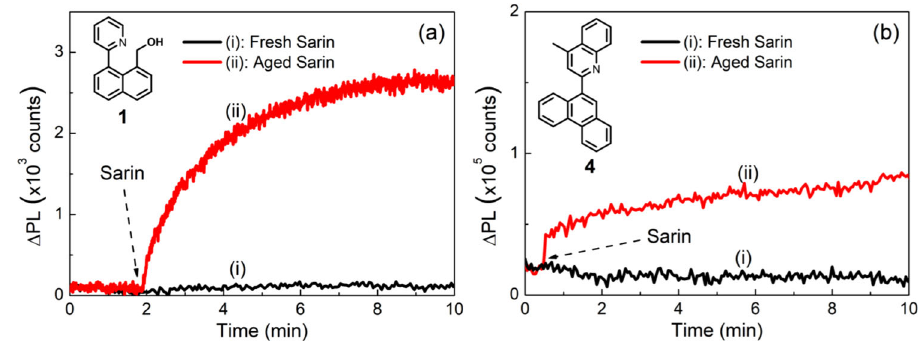
Fig. 11 Sensing results of fi lms of 1 and 4 upon exposure to freshly prepared and aged Sarin. Representative PL kinetics curves for ( a ) 10 wt% 1 :cellulose acetate and ( b ) 10 wt% 4 :cellulose acetate sensing fi lms exposed to vapors of aged (being stored for more than 6 months) and fresh (prepared and distilled twice less than one week before use) Sarin using the Supplementary Fig. S2a setup. The PL kinetics were recorded using an OceanOptics